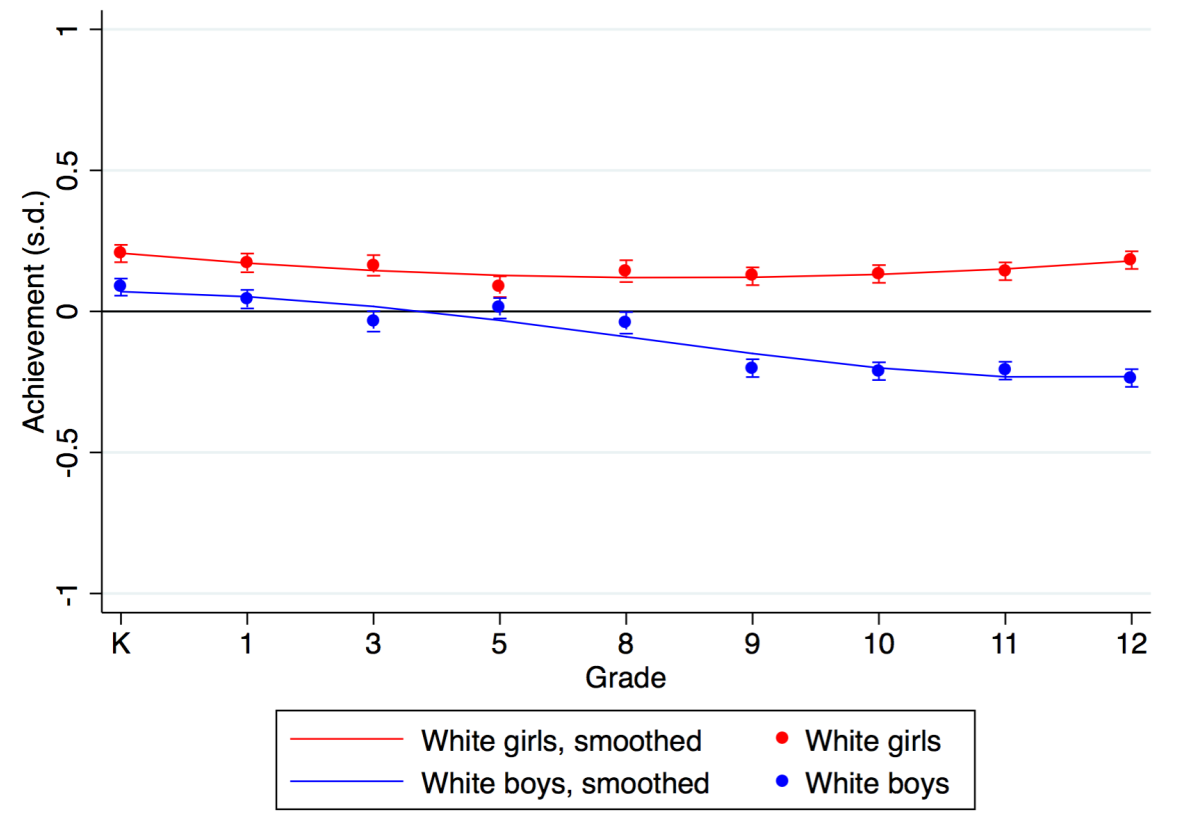
Figure 1: Gender gap in achievement among whites. Note : The figure plots the predicted achievement scores for white girls and boys from unadjusted school-fixed effect regressions. Kindergarten to eighth-grade scores come from the ECLS-K, and ninth- to 12th-grade scores come from the